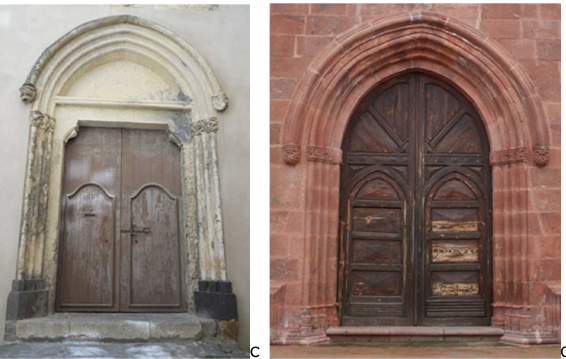
Figure 2. Studied portals: c) Cagliari, La Speranza; d) Allai, Santo